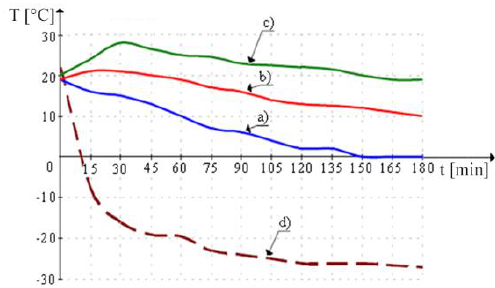
Figure 3. Characteristics of UIC-60 (60 E1) [UIC— Union internationale des chemins de fer ] rail web heating with a 330 W/m heater: ( a ) without heat insulation, ( b ) with heat conducting heat insulation, ( c ) with heat conducting and insulating heat insulations, and ( d ) temperature in the climatic chamber [5].